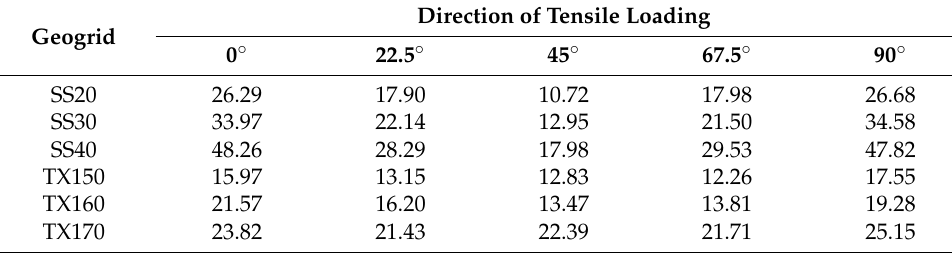
Table 1. Tensile strength of geogrids for loading in different directions (kN/m).